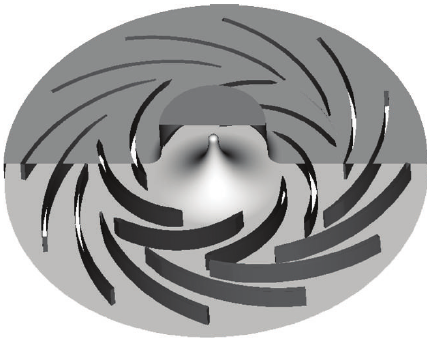
Figure 1: Geometry of the ERCOFTAC centrifugal pump.